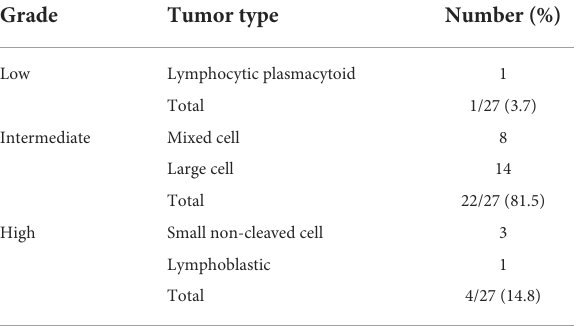
TABLE 5 Frequency of distribution in 27 cases of feline spinal lymphomas classified according to the National Cancer Institute working formulation (NCI